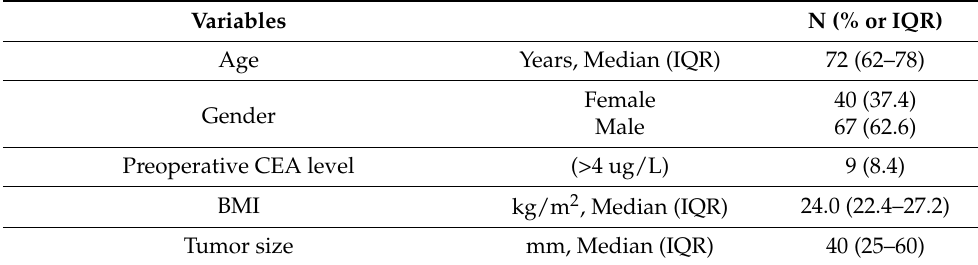
Figure 2. Study flowchart. Table 1. Patients’ demographic, clinical, and treatment